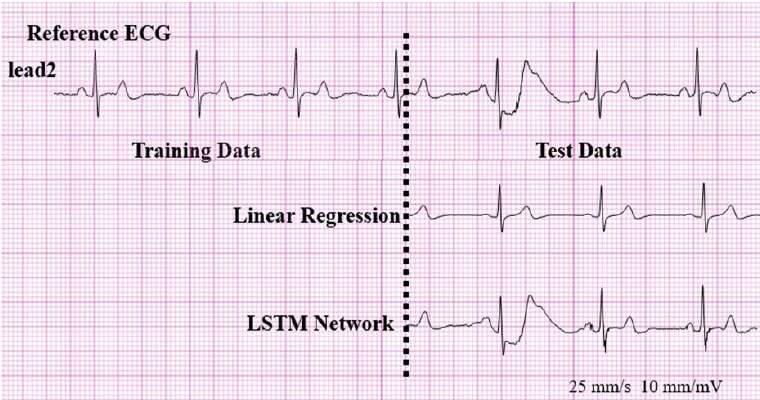
Figure 11. Reproduction of the ventricular ectopic beats that are not present in the 5 s training data.